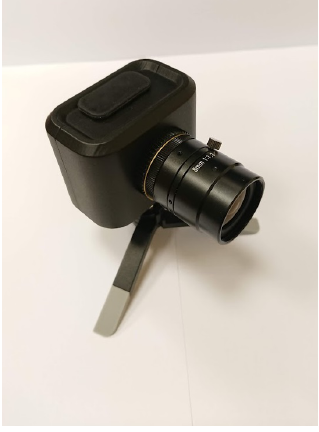
Figure 10. Dynamic vision